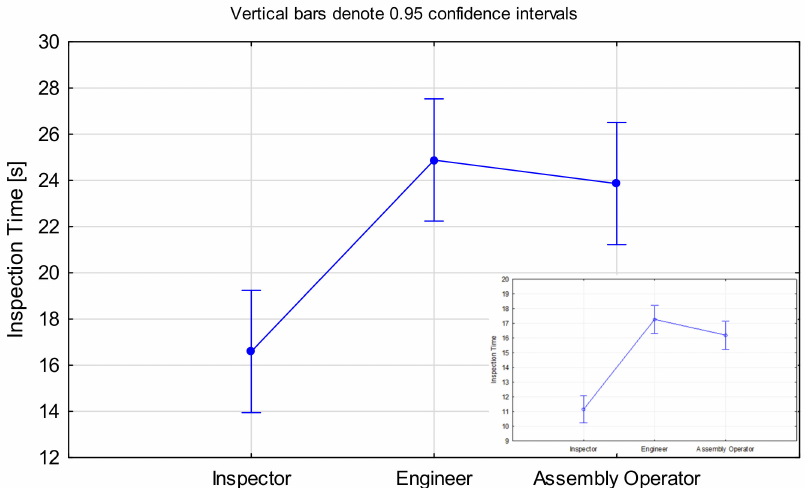
Figure 11. Mean plot of inspection time by expertise. The results of [6] are shown in the bottom-right corner for comparison (Reprinted with permission from ref. [6]. Copyright 2021 MDPI Aerospace).